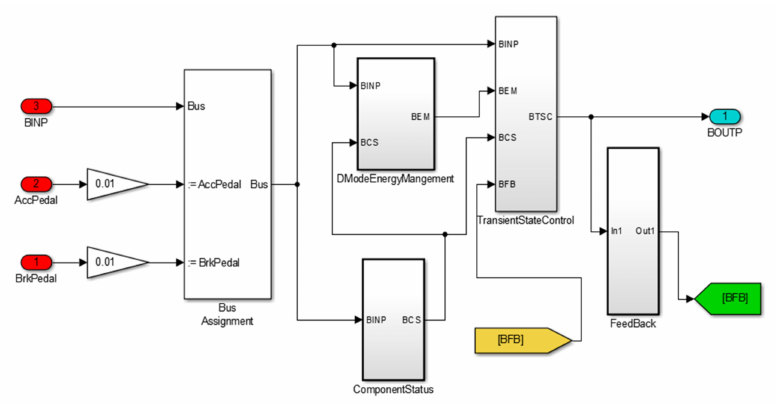
Figure 5. Controller